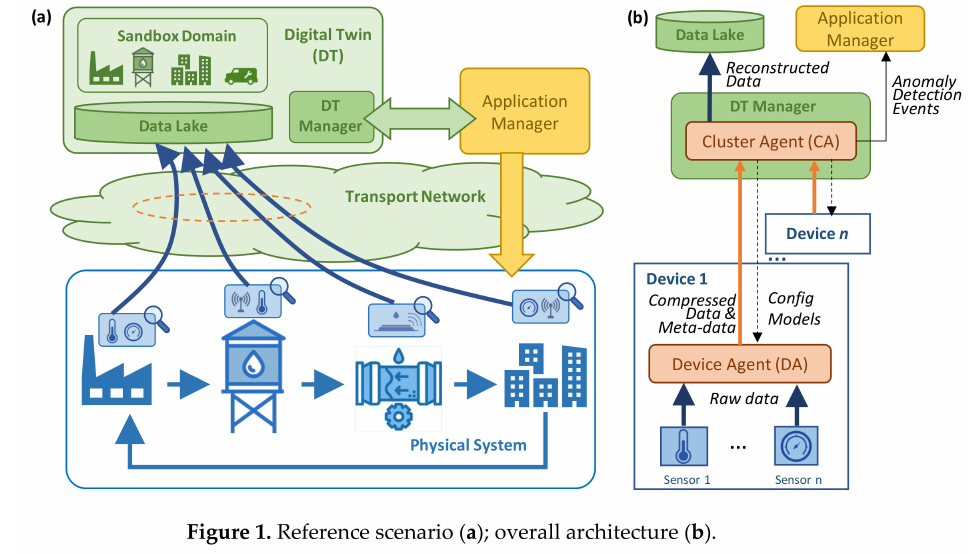
Figure 1. Reference scenario ( a ); overall architecture ( b